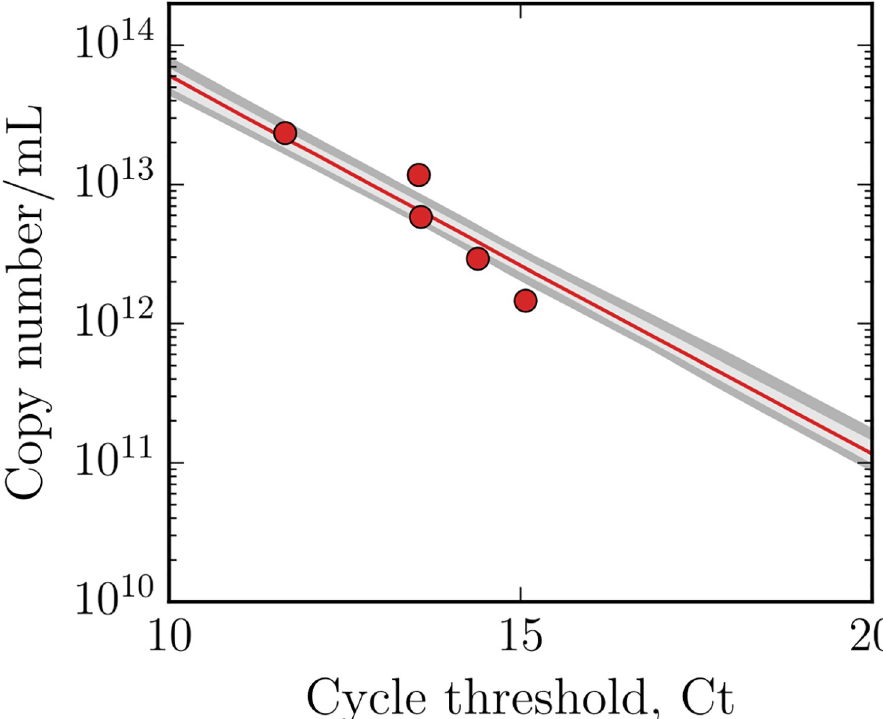
Fig 3. Standard RT-qPCR curve. Cycle threshold values (Ct) were converted to total virus (copy/mL) using the above calibration curve, where the parameters of the curve were estimated as a part of the analysis. The lines represent the pointwise median bracketed by 68% (light grey) and 95% (dark grey)